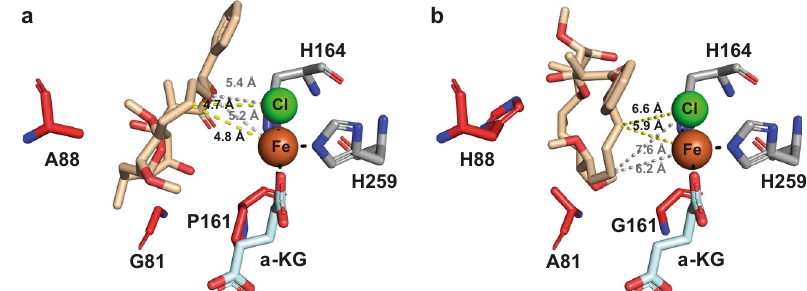
Fig. 4 Soraphen A (wheat) docked models of the regio-divergent WelO5* variants GAP and AHG. a In the model of WelO5* variant GAP (amino acids G, A, and P shown as red sticks) shorter distances between the iron and chloride to C14 of soraphen A (yellow dotted lines) than to C16 of the macrolide (gray dotted lines) suggest the structural reason for the predominant formation of regioisomer 1a . b In the soraphen A docked model of WelO5* variant AHG (amino acids A, H, and G shown as red sticks), a shift in substrate positioning leads to shorter distances between the iron and chloride to C16 of soraphen A (yellow dotted lines) than to C14 of the macrolide (gray dotted lines) underlining the observation of selectivity for formation of regioisomer 1b . Histidine residues (gray) and the α -ketoglutarate (pale cyan) in complex with the iron (orange sphere) are shown as sticks. The chlorine coordinating to the iron is shown as a green